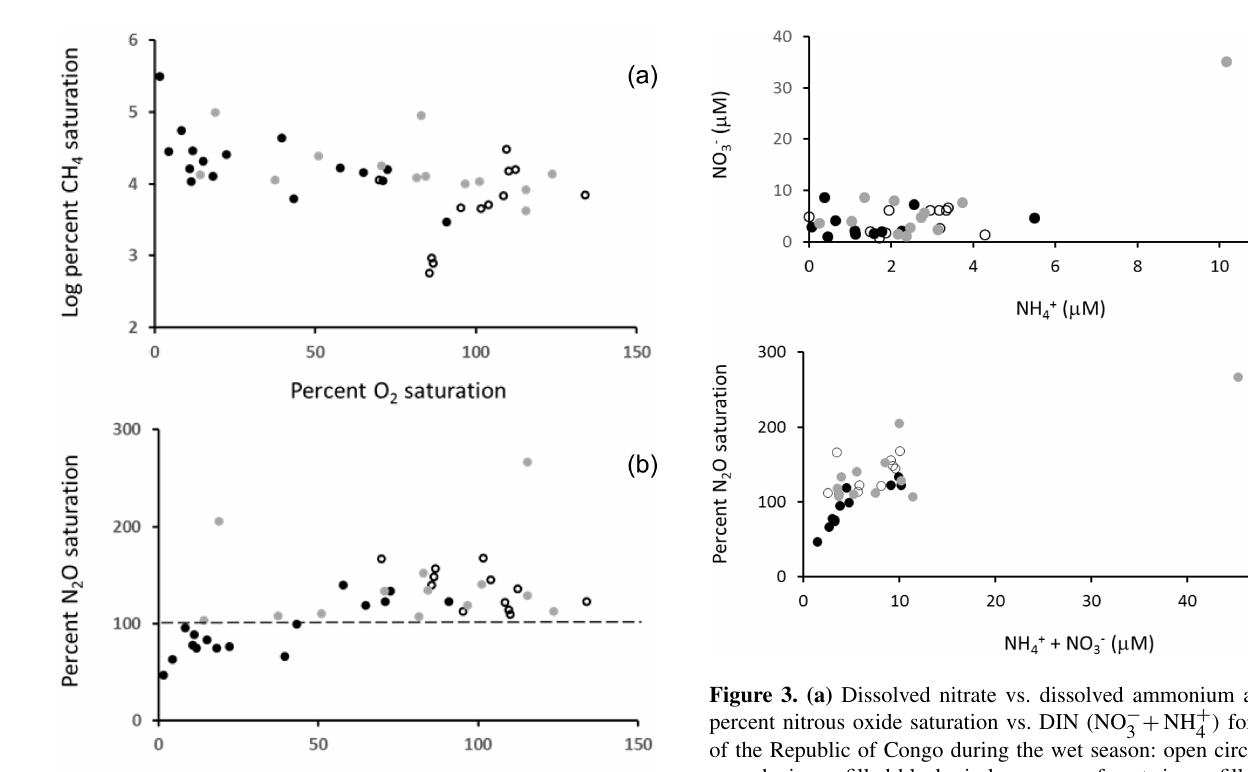
+ NH + ) for rivers 3 4